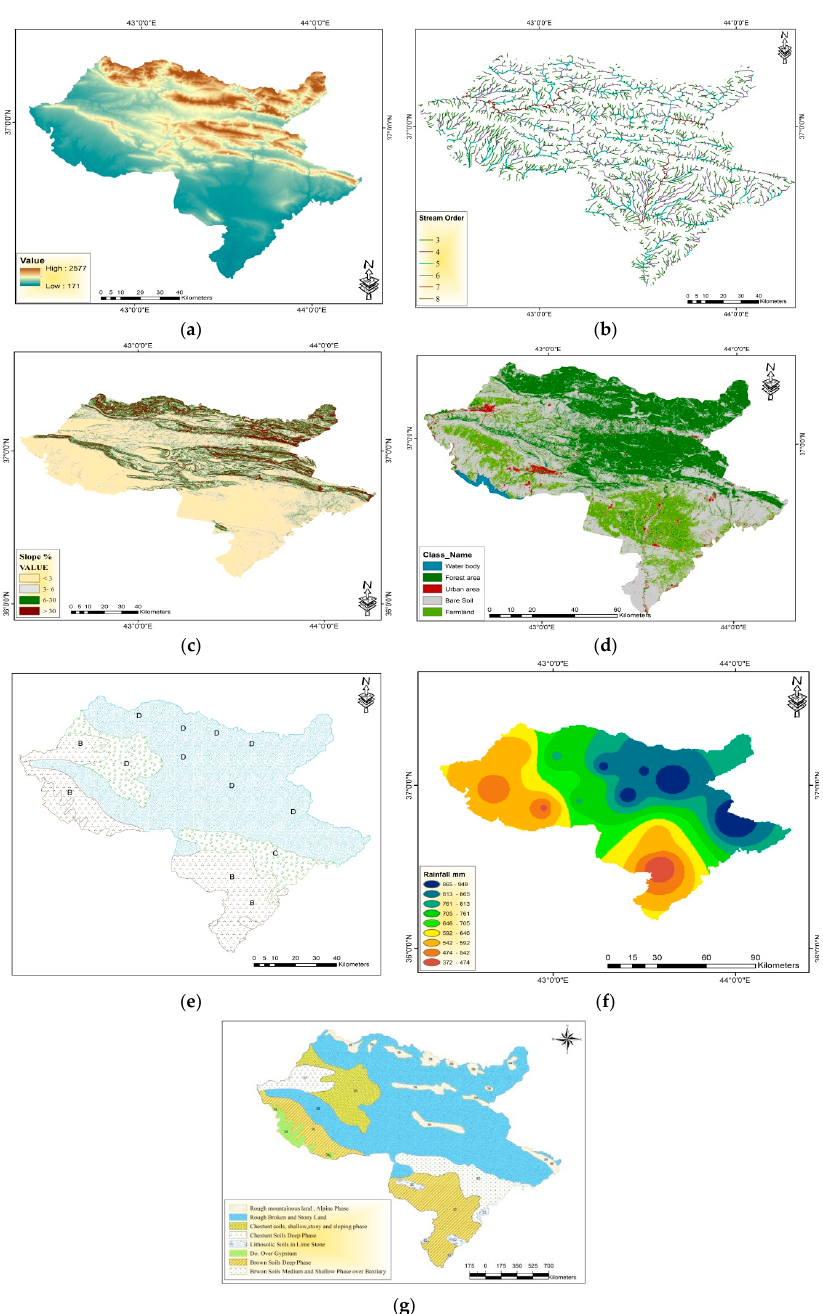
Figure 2. ( a ) Digital elevation model; ( b ) Drainage area; ( c ) Slope; ( d ) Classified land use; ( e ) Soil classes (B: Silt loams or loamy soils (0.38 to 0.76 cm / h), C: sandy clay loams (0.13 to 0.38 cm / h), D: high runo ff potential soils (0 to 0.13 cm / h)); ( f ) Average annual rainfall; ( g ) Soil